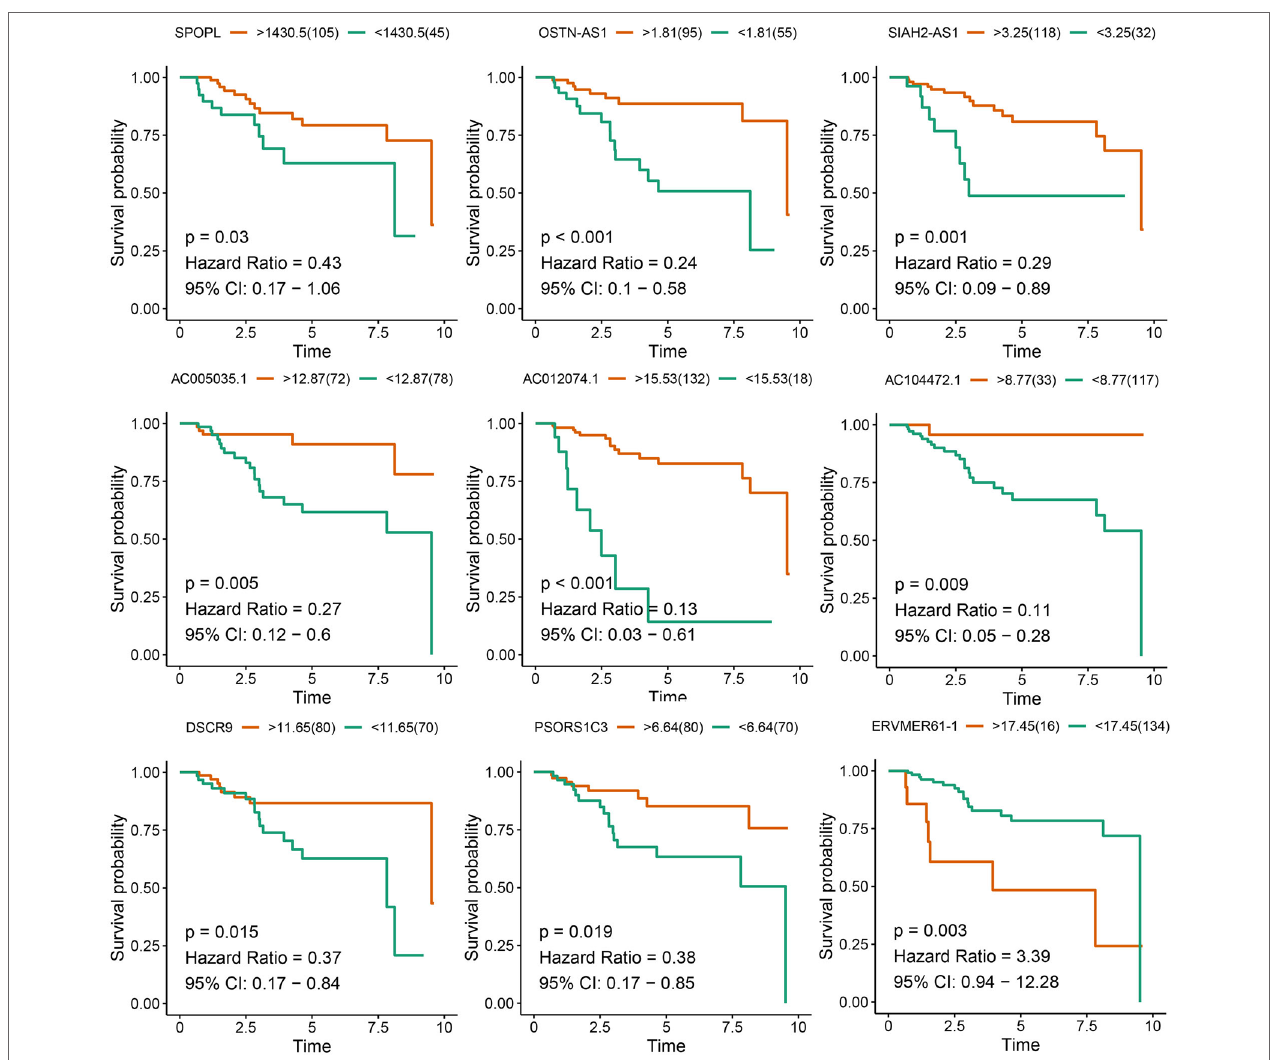
FIGURE 2 | Analysis of prognostic RNAs screened from the ceRNA network. Overall survival analysis of 8 lncRNAs and mRNA SPOPL in